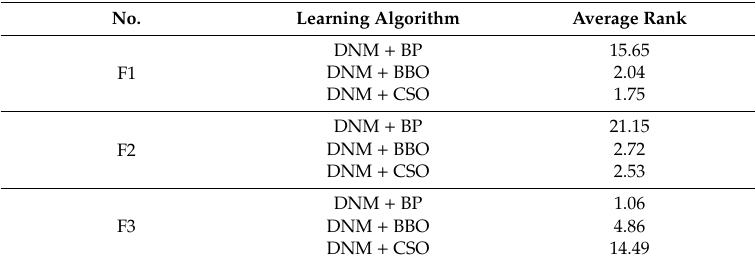
Table 20. Standard deviation of average accuracy of each method for the